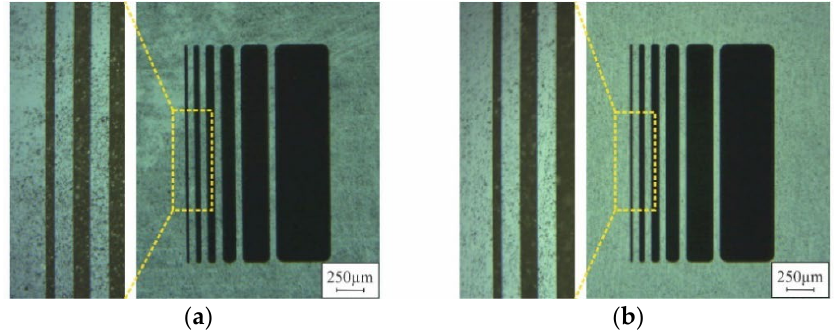
Figure 13. Photographs of chips of M5 design on substrates after ( a ) manual and ( b ) automated mold filling of NdFeB particles and subsequent agglomeration by ALD.